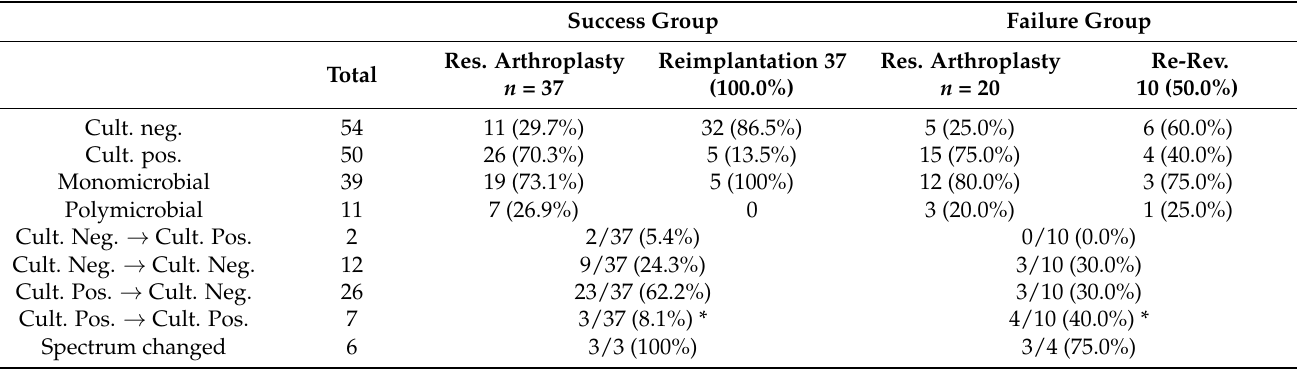
Table 2. Comparison of microbiological results and microbiological changes between successful two-stage procedures (success group) and failed two-stage procedures (failure group).